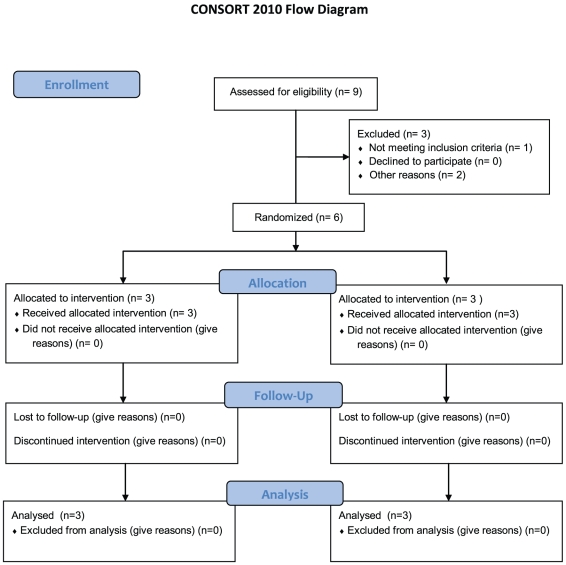
CONSORT 2010 Flow Diagram.Flow diagram of enrollment, allocation, follow-up and analysis of the Zenapax® Activated Peptide Immunotherapy (ZAP IT) Clinical Trial.